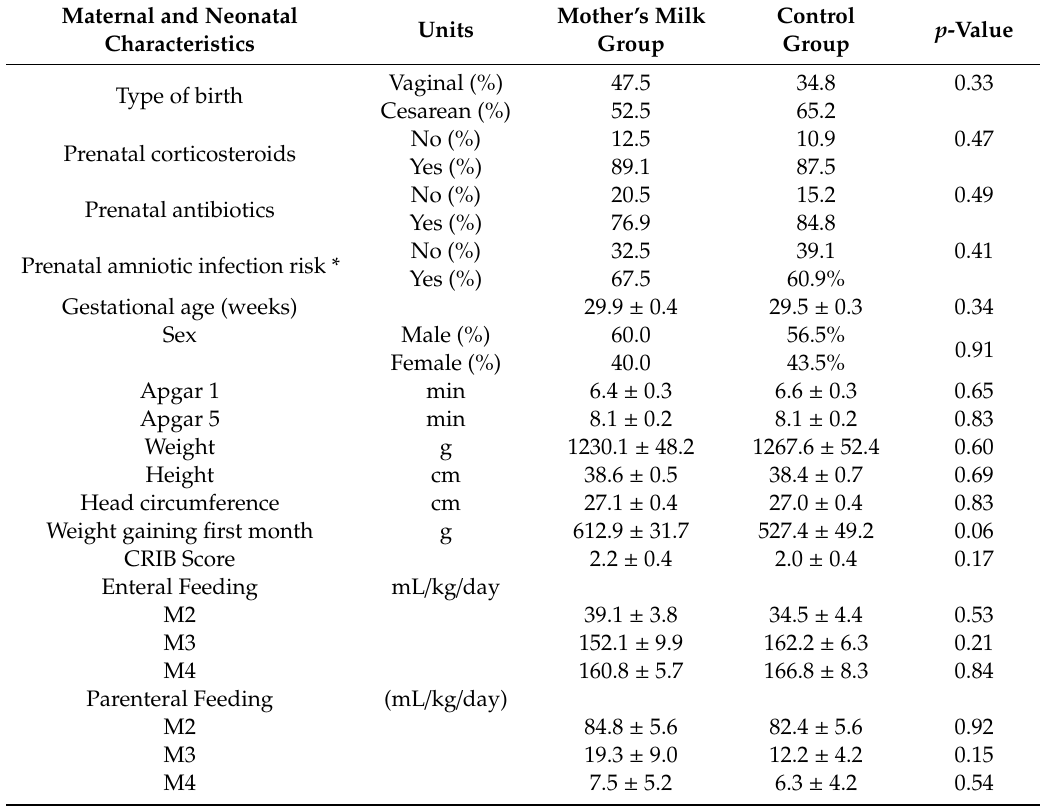
Table 1. Maternal and neonatal general characteristics.